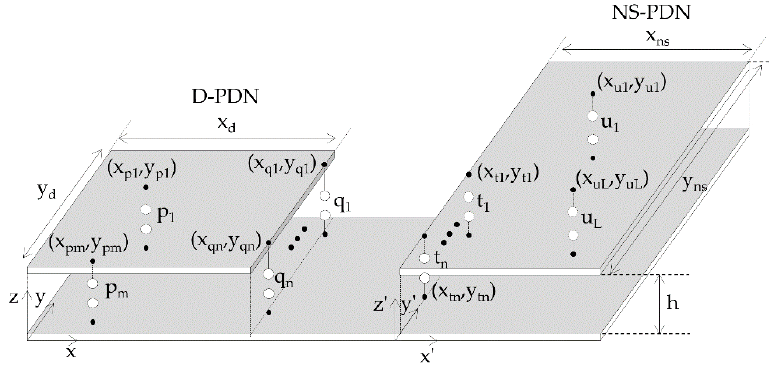
Figure 9. Port definitions of D- and NS-PDNs for extraction of Z-parameters.